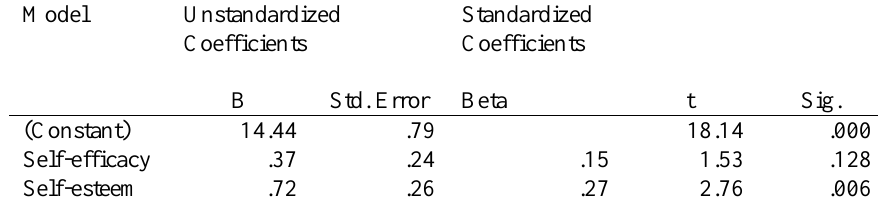
Multiple regressions for the predictive power of general self-efficacy and self- esteem